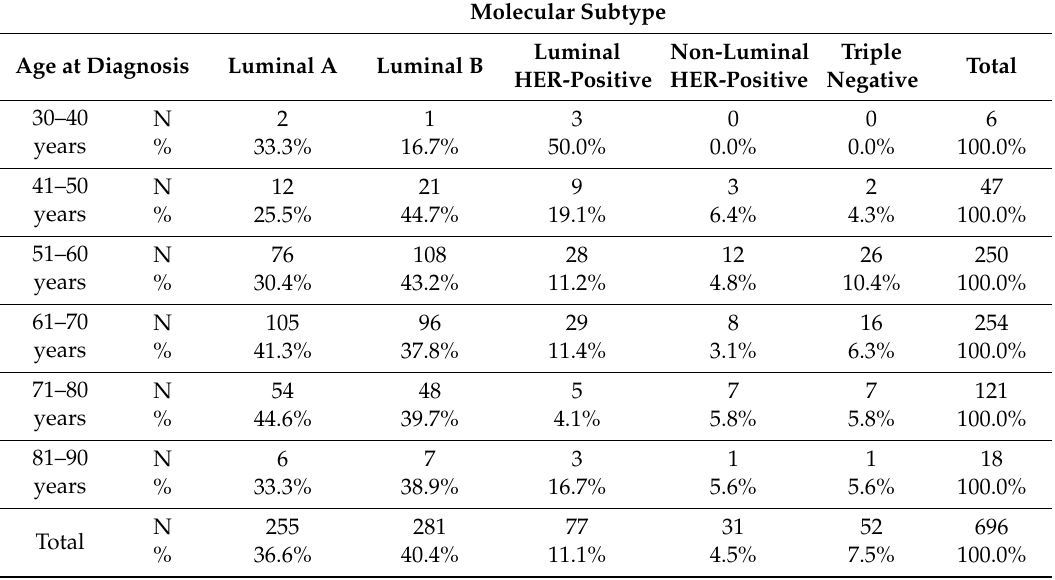
Table 2. Age groups and luminal subtypes.